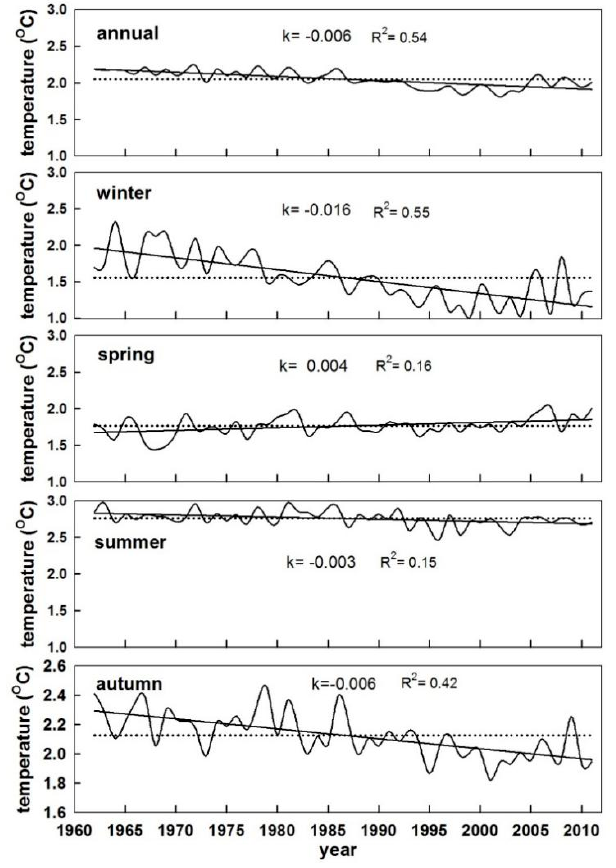
Figure 8. Linear trends from annual means of daily T D on annual and seasonal scales in China during 1962–2011. Dashed lines represent averages. K represents the slope (i.e., the rate of change ( ◦ C / year)); all the slopes of trends were significant ( p < 0.05).